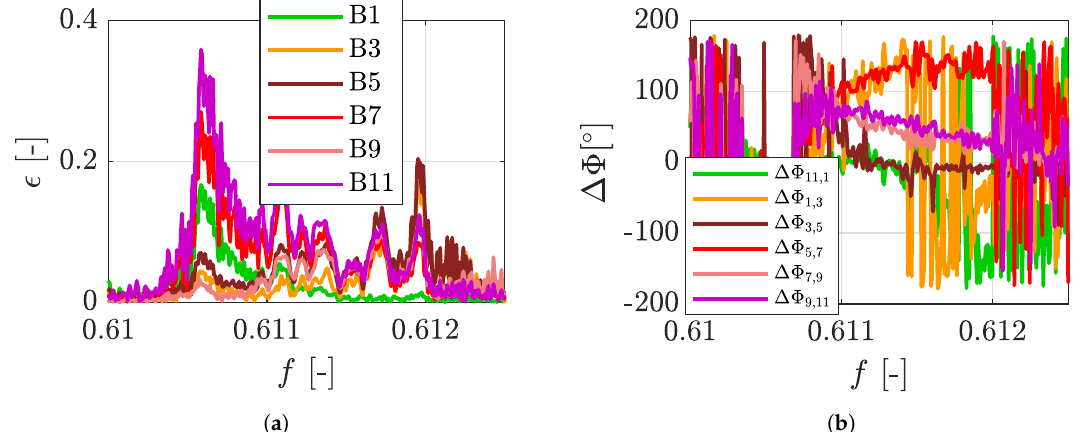
Figure 13. EO17: Frequency domain and phase lag. The same legends as displayed in Figure 7 apply. ( a ) Zoom on EO17 excited normalized amplitude of all SG-applied blades during rotational speed of M8EO24; ( b ) Zoom on EO17 excited phase lag ∆ Φ i , i + 2 of all SG-applied blades during rotational speed of M8EO24.